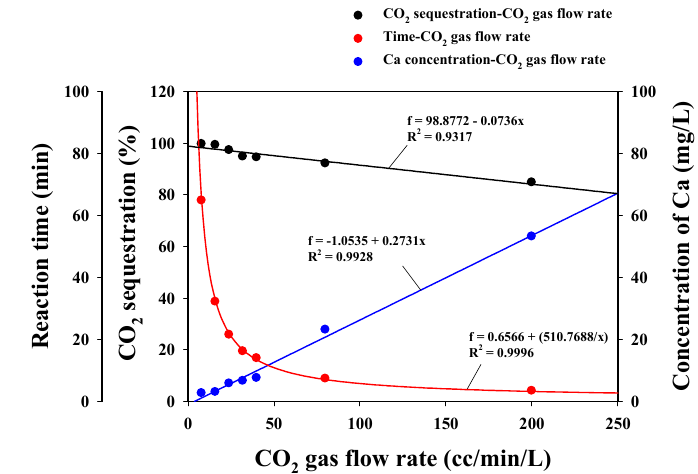
Figure 7. Correlation between CO 2 sequestration, reaction time and residual Ca concentration and CO 2 gas flow rate during the carbon mineralization processes.